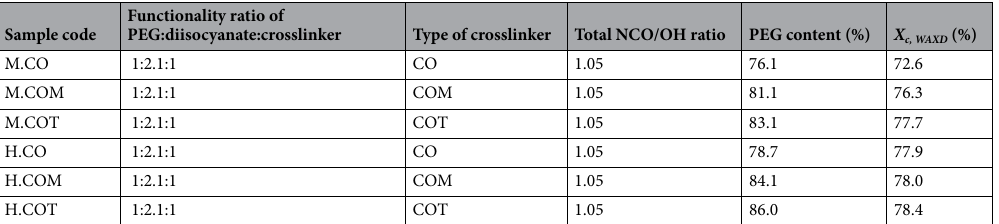
Table 1. Composition of the synthesized